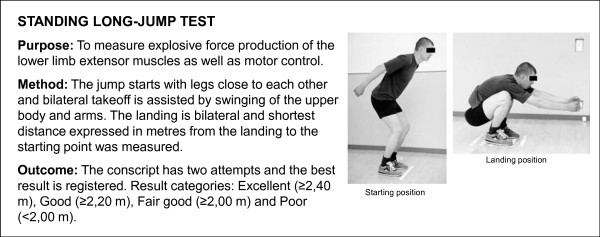
Description of standing long jump test. The test is based on practice in the Finnish Defence Forces.